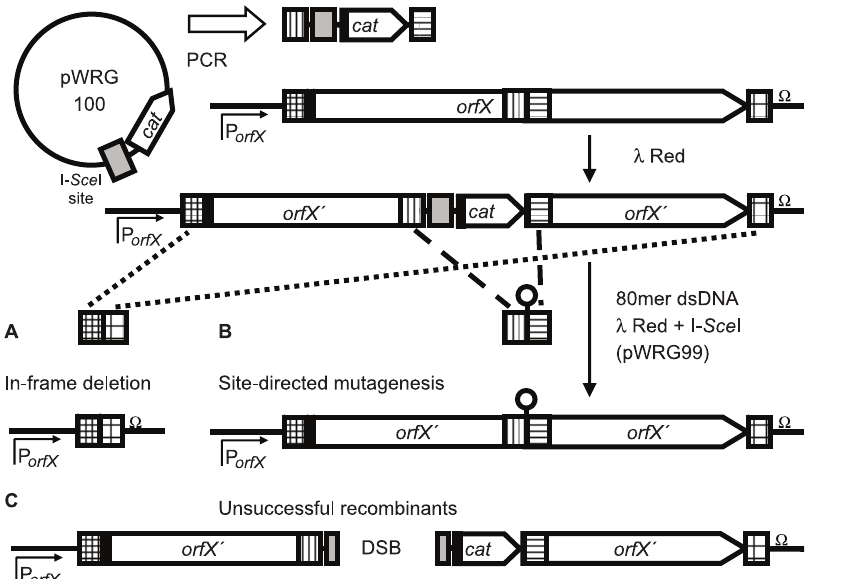
Figure 1. Rationale of the recombineering method. A chloramphenicol resistance cassette ( cat ) is amplified together with an I- Sce I recognition site (grey bars) from plasmid pWRG100 by PCR using primers with 40 bp homology extensions (vertical and horizontal hatching). After integration within a target gene ‘‘ orfX ’’ via l Red-mediated recombination, the mutant can be used (A) to generate an in-frame deletion: A 80mer dsDNA is designed to comprise sequences homologous to flanking regions of orfX (cross-hatched). (B) Site-directed mutagenesis of the region adjacent to the I- Sce I recognition site: is done with the help of a synthetic 80mer mutant dsDNA fragment harboring the same homologous regions used for integration of the resistance cassette (vertical and horizontal hatching). In a second l Red-mediated recombination step the 80mer dsDNA is integrated within the genome. Use of plasmid pWRG99 at this point allows for sequential expression of I- Sce I after recombination which leads to effective killing of unsuccessful recombinants by induction of DSBs (C). doi:10.1371/journal.pone.0015763.g001 PLoS ONE |